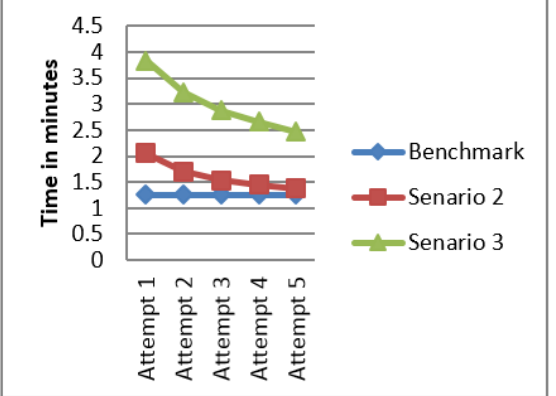
Figure 5. Average time of benchmark and all